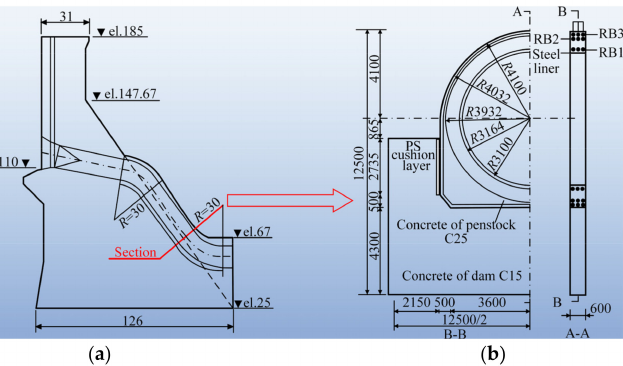
Figure 3. A 1:2 large-scale prototype model of the Three Gorges HPP: ( a ) penstock longitudinal profile (unit: m); ( b ) cross-section details of the penstock (unit: